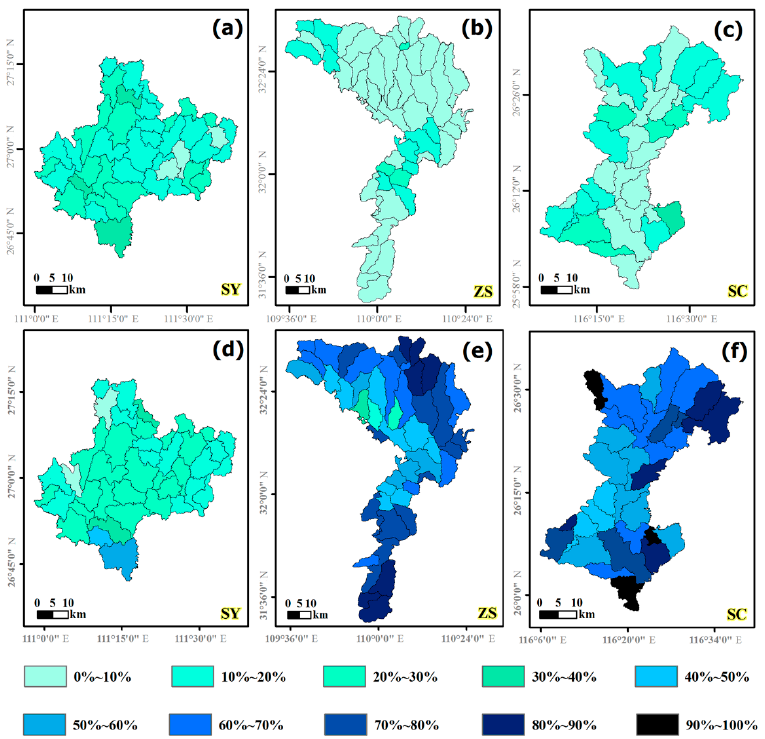
Figure 6. Percentage of plantations and natural forests in 2013 at the watershed scale ( number of sub-basins, n = 35, 42, and 32 in SY, ZS, and SC). ( a – c ) Percentages of plantations in SY, ZS, and SC. ( d – f ) Percentages of natural forests in SY, ZS, and SC.